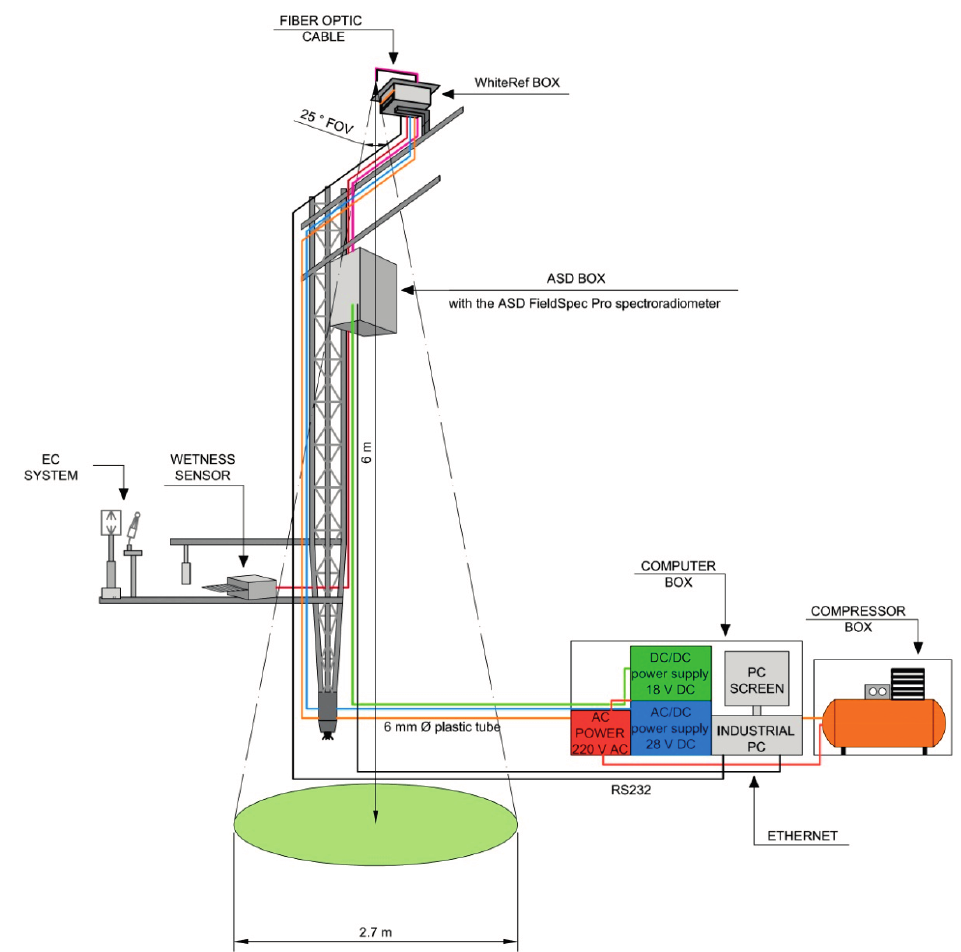
Figure 2. Schematic drawing of the WhiteRef hyperspectral system deployed at the EC